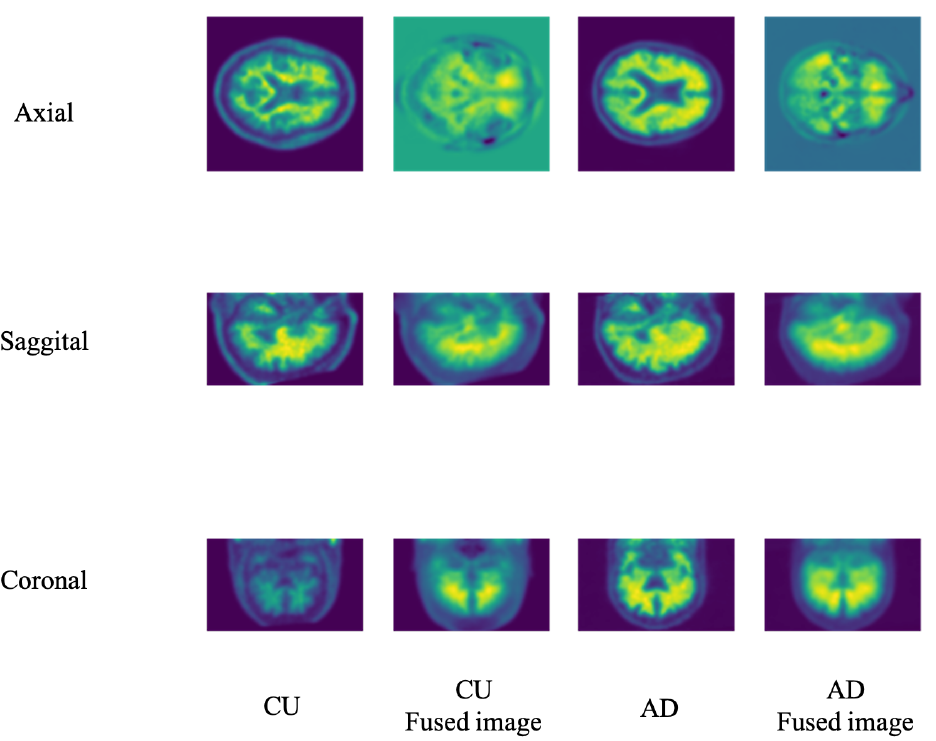
Figure 4. The different views of the 3D Brain image slice and the corresponding 3D-to-2D fused image. Based on the axial, sagittal, and coronal views, the 3D PET image size is 96 × 160 × 160. The corresponding fusion images of PET under different views are different: 160 × 160 of axial view, 96 × 160 of sagittal view, and 96 × 160 of coronal view. Table 3. The performance results of LWP on different views of the 3D brain image.